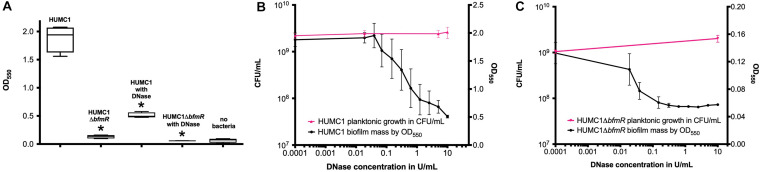
Panel (A) Optical density at 550 nm after crystal violet biofilm staining for HUMC1 and HUMC1ΔbfmR with and without 10 U/mL DNase after incubation in Mueller Hinton II cation-adjusted broth for 24 h at 37°C. Values are means, boxes the 25th and 75th percentile, whiskers minimum and maximum. HUMC1 mean absorbance = 1.88 ± 0.12; HUMC1 with DNase mean absorbance = 0.51 ± 0.02, P < 0.0001). HUMC1ΔbfmR mean absorbance = 0.1325 ± 0.01564; HUMC1ΔbfmR with DNase mean absorbance = 0.0575 ± 0.001323, P = 0.0031). Data are means ± SEM, with comparisons by unpaired t test, n = 4. Panel (B) Optical density at 550 nm after crystal violet biofilm staining for HUMC1 at DNase concentrations 0–10 U/mL, with corresponding growth of planktonic bacteria in CFU/mL. Panel (C) Optical density at 550 nm after crystal violet biofilm staining for HUMC1ΔbfmR at DNase concentrations 0–10 U/mL, with corresponding growth of planktonic bacteria in CFU/mL.